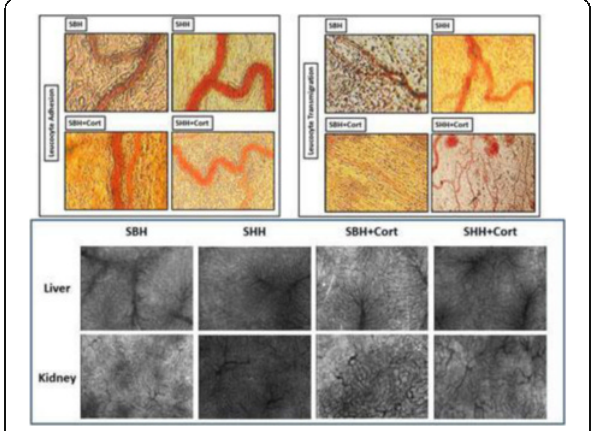
Fig. 142 (abstract A388). Mesenterial, liver and Kidney